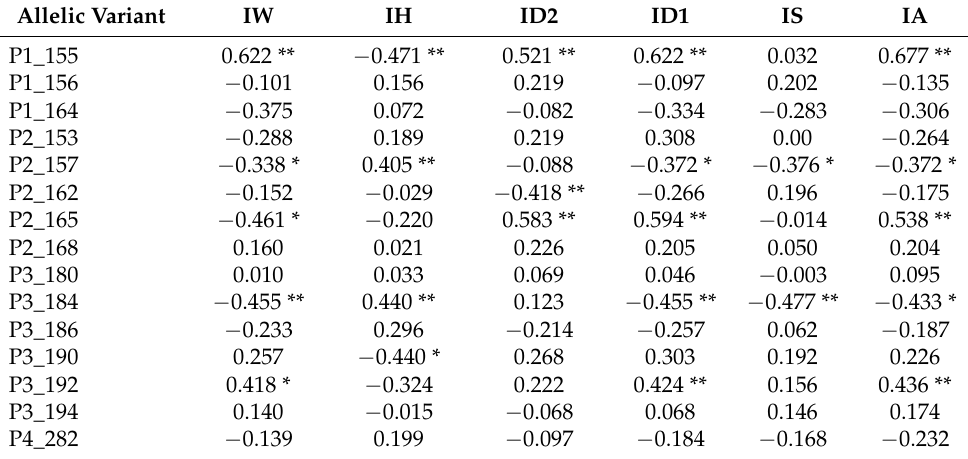
Table 3. Correlation among all the allelic variants detected by the molecular markers used and the analyzed traits to individuate the most associated alleles of the examined